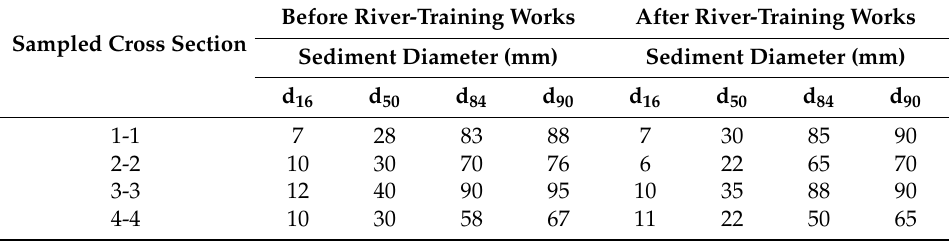
Table 3. Characteristic grain size for the Lososina River before and after river-training works. Before River-Training Sampled Cross Section